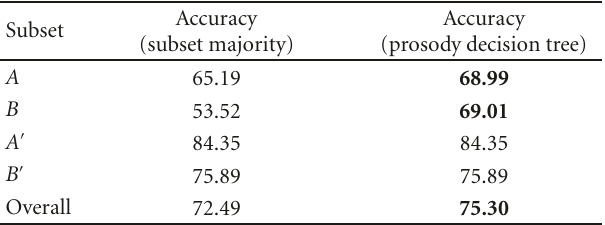
Table 3: Accuracies for classifyingself-reported level ofcertainty for the prosodic decision tree models trained separately on each of the four subsets of utterances. For subsets A and B , the decision trees perform better than assigning the subset-majority class, while for subsets A (cid:2) and B (cid:2) , the decision trees do no better than assigning the subset-majority class. The combined decision tree model has an overall accuracy of 75.30%, significantly better than the single- decision tree